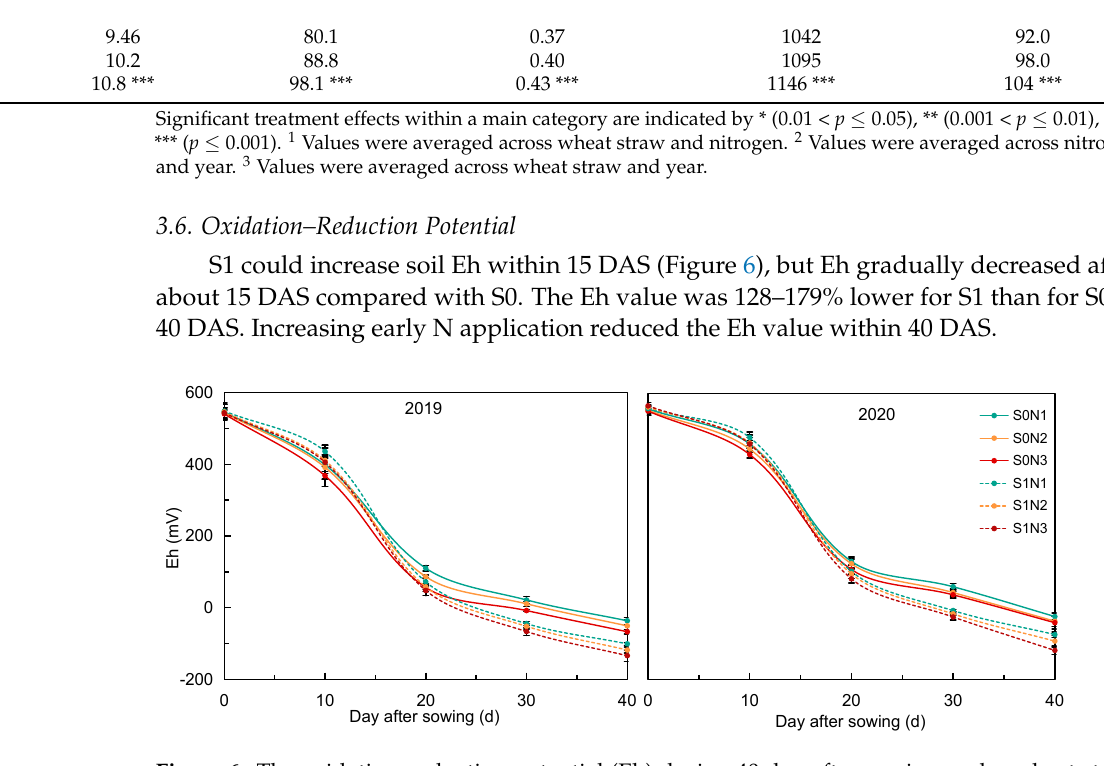
Table 5. Root morphological characteristics at 35 days after sowing as affected by wheat straw re- turning (S0 or S1; n = 18), nitrogen (N1, N2, or N3; n = 12), and year (2019 or 2020; n = 18).